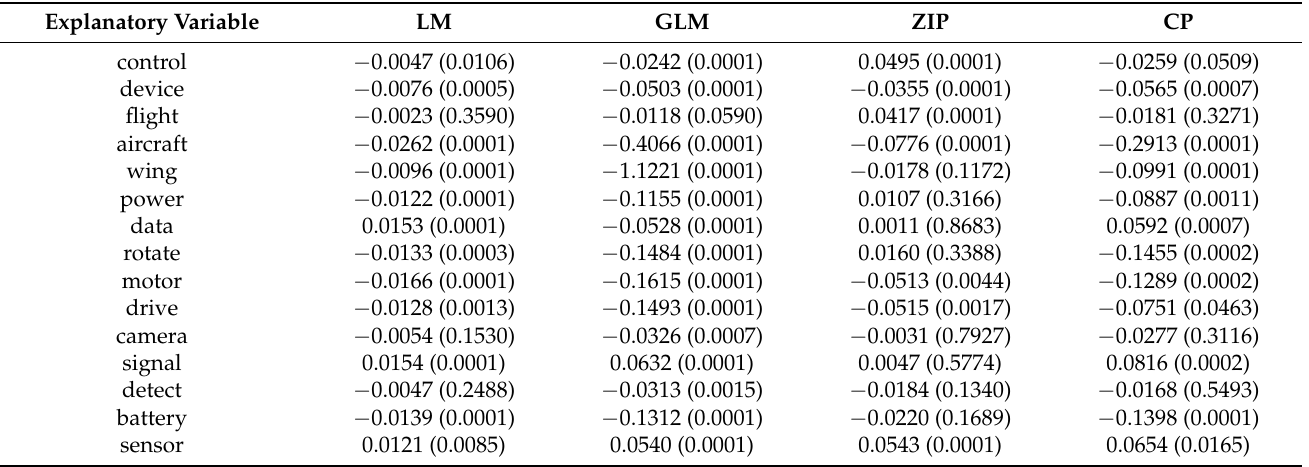
Table 5. Analysis results of comparative models using patent